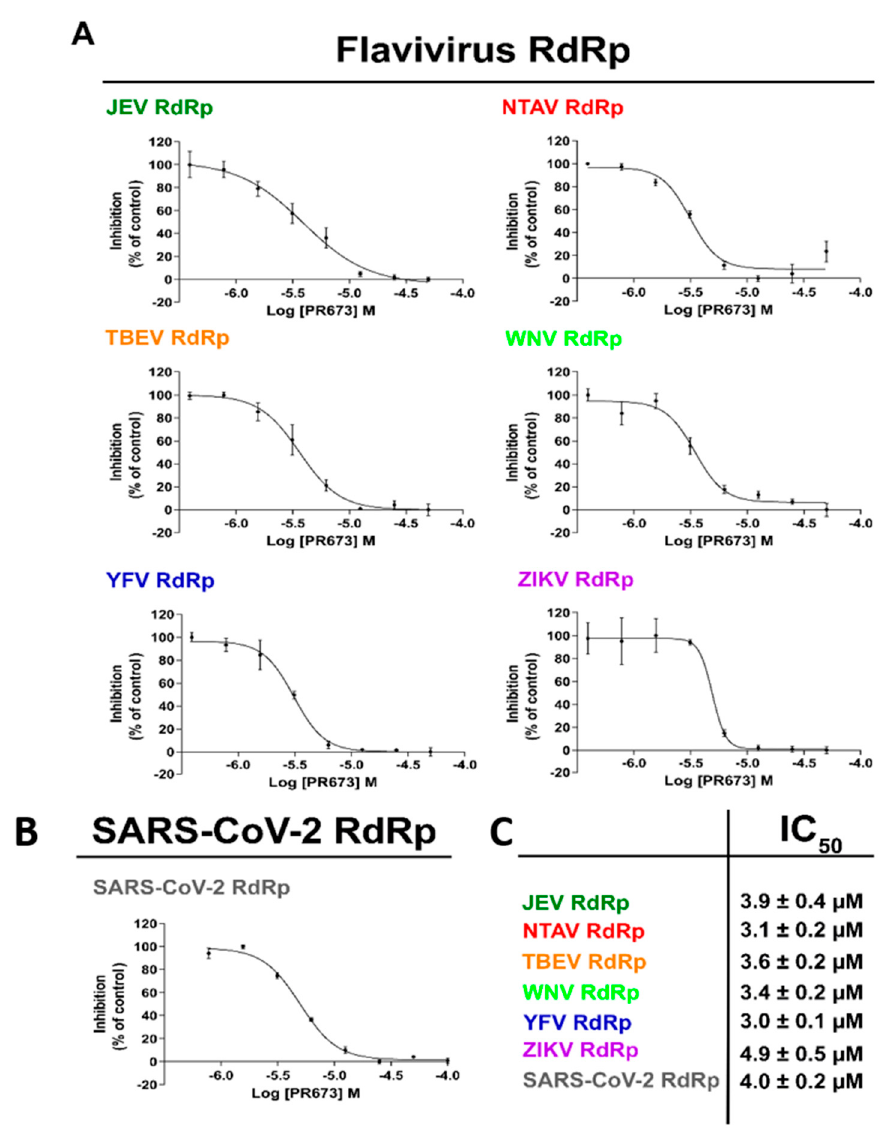
Figure 3. Measurement of the IC 50 values of PR673. The IC 50 values were established for each tested polymerase with PR673 using radioactively labeled elongation products. ( A ) The RNA hairpin used in this assay. The arrow indicates the direction of primer extension. ( B ) The percentages of inhibition (against control) were plotted against the logarithm of concentrations of PR673, and the results were fitted to sigmoidal dose–response curves. Error bars represent the standard error of three independent measurements. ( C ) The table of IC 50 values. The IC 50 values were extrapolated from LogIC 50 according to the GraphPad algorithm.